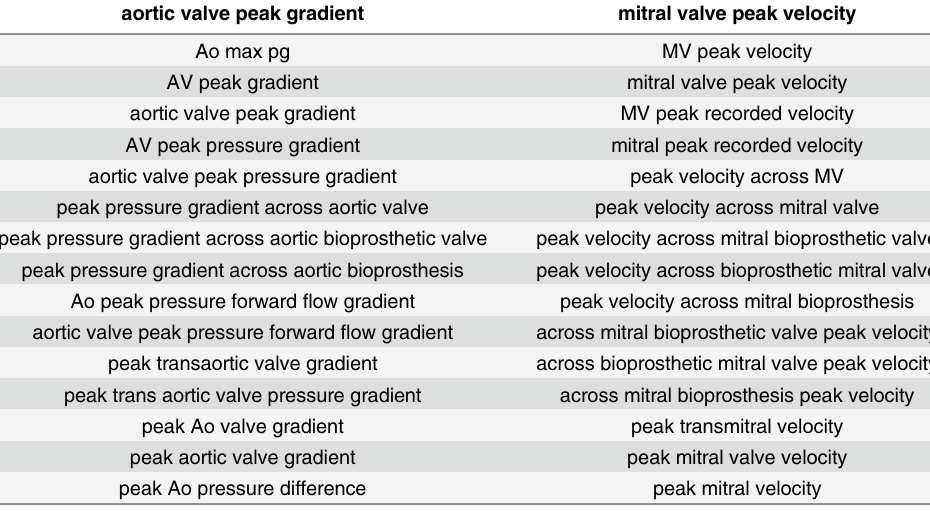
Table 5. Examples showing various synonymous terminologies used in echocardiography reports for data elements targeted for EchoInfer extraction.